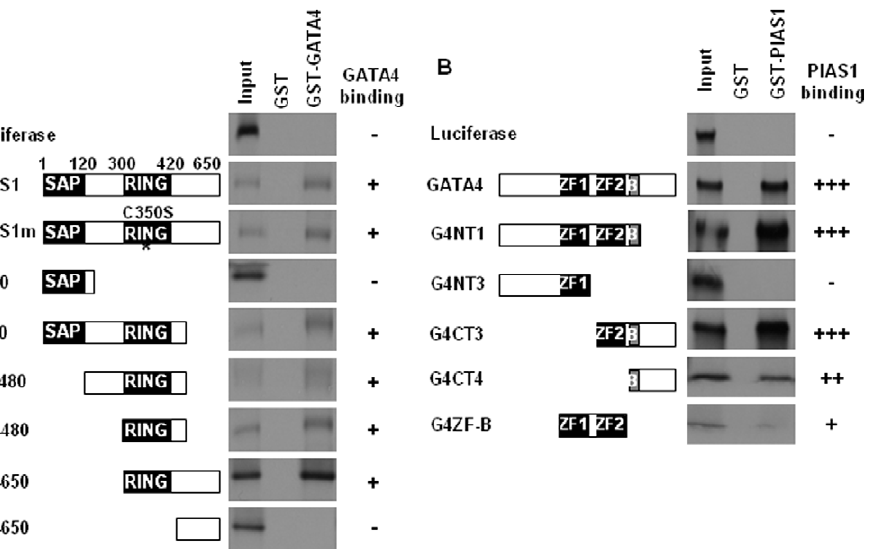
Figure 2. Second zinc finger and the adjacent basic region of GATA4 and the RING finger and the adjoining C-terminal sequences of PIAS1 mediate physical association. GST pull down experiments were performed using [ 35 S] methionine labeled wild-type or indicated mutants of PIAS1 and purified GST fused GATA4 protein or GST protein immobilized on glutathione-sepharose beads ( panel A ). In panel B , converse experiments in which purified GST or GST fused PIAS1 protein immobilized on glutathione beads were used to pull down [ 35 S] methionine labeled wild-type or indicated mutants of GATA4 protein is shown. The domains present in deletion mutants are diagrammatically indicated. The asterisk embedded in the RING domain of PIAS1m indicates that this protein carries a C350S mutation that inactivates the SUMO ligase activity.